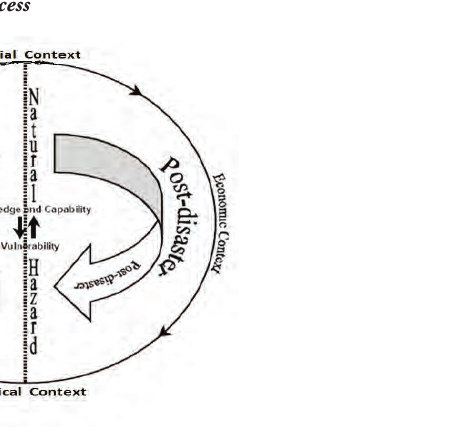
Figure 1: Vulnerability and capacity as dynamic